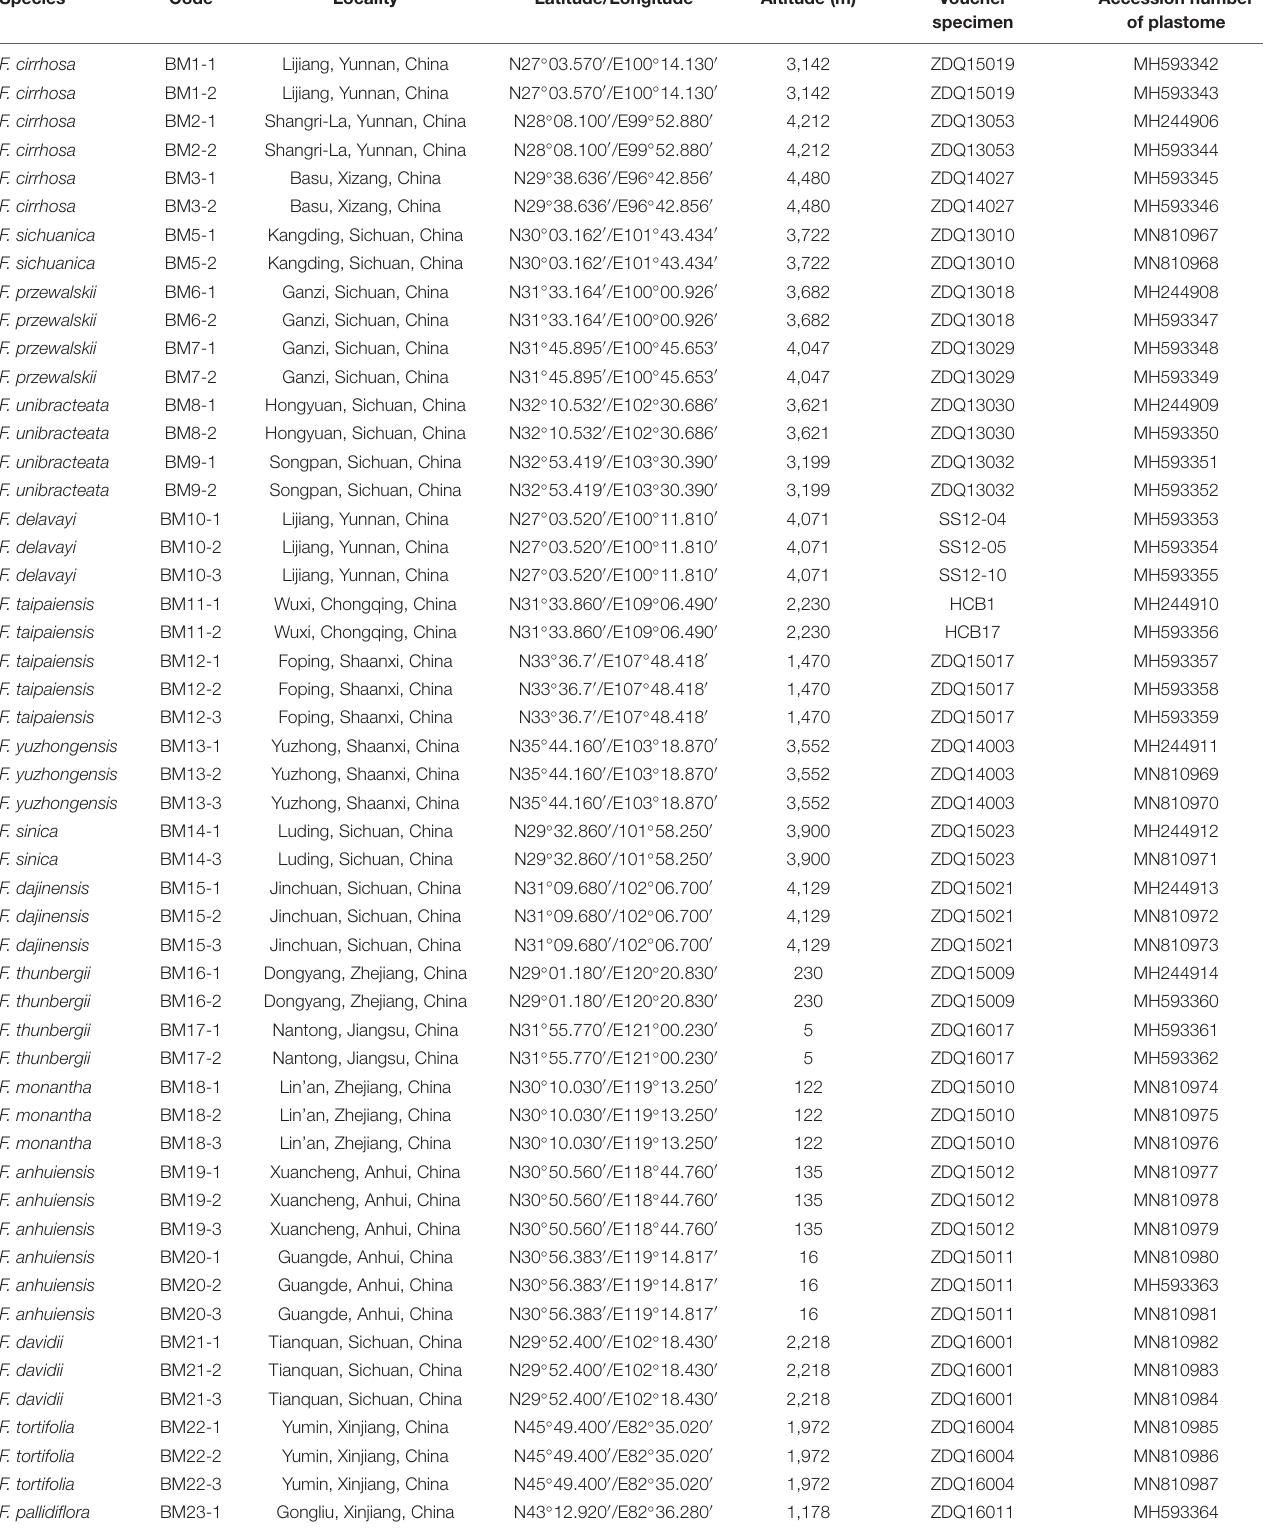
TABLE 1 | Collecting information of the 21 species (including the suspicious species) in Fritillaria in China. Species Code Locality Latitude/Longitude Altitude